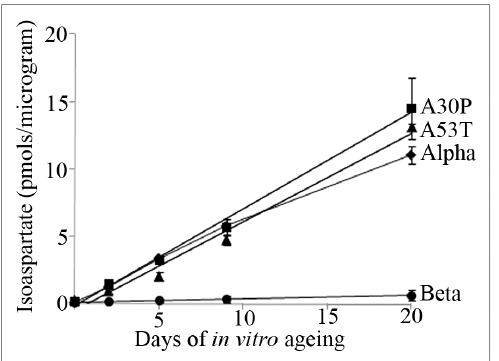
Figure 5. Quantitation of isoaspartate protein damage after in vitro ageing of synucleins. Native a -synuclein, b -synuclein, A30P mutant a -synuclein, or A53T mutant a -synuclein were in vitro aged over a time course of 20 days. Two and a half m g of protein was removed after 0, 2, 5, 9, and 20 days of in vitro ageing and the level of isoaspartate formation quantified by a methanol diffusion assay.